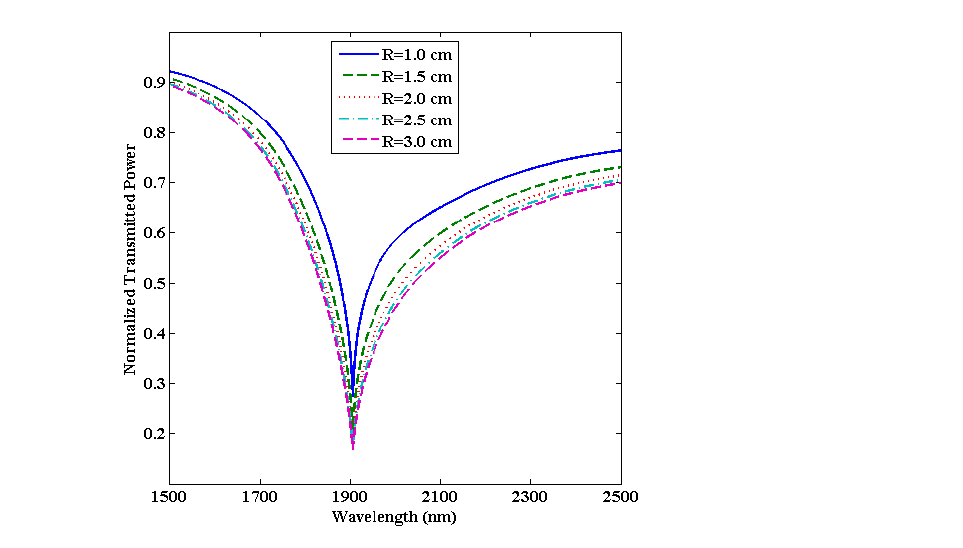
Figure 9. Transmitted LMR spectra (only the first LMR curve) for various bending radii of an ITO-coated U-shaped fiber optic LMR sensor. Here, SMRI = 1.33, d = 90 nm, and L = 0.5 cm.